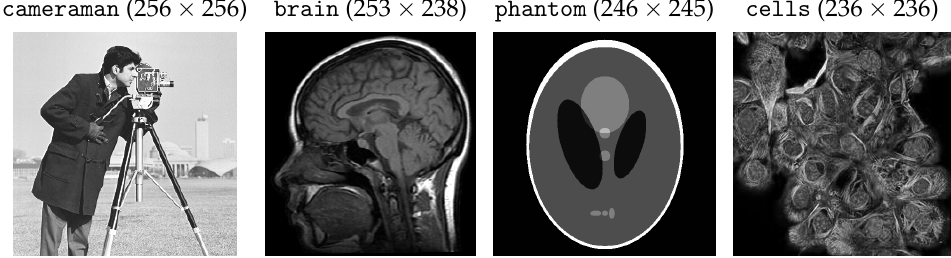
Figure 5. Grayscale test images considered for the numerical